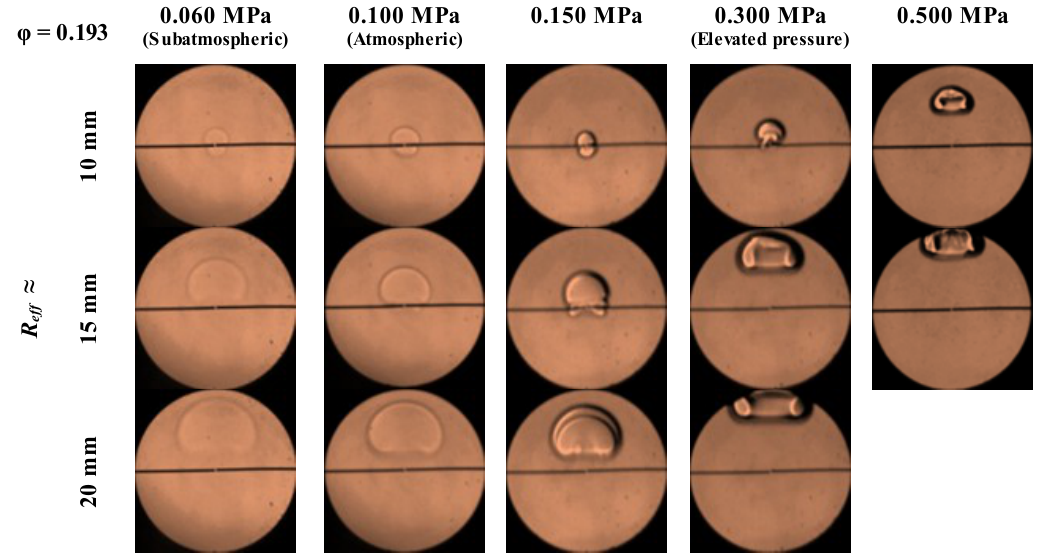
Figure 5. Schlieren images of hydrogen-air premixed flames with φ = 0.193 at different pressures and room